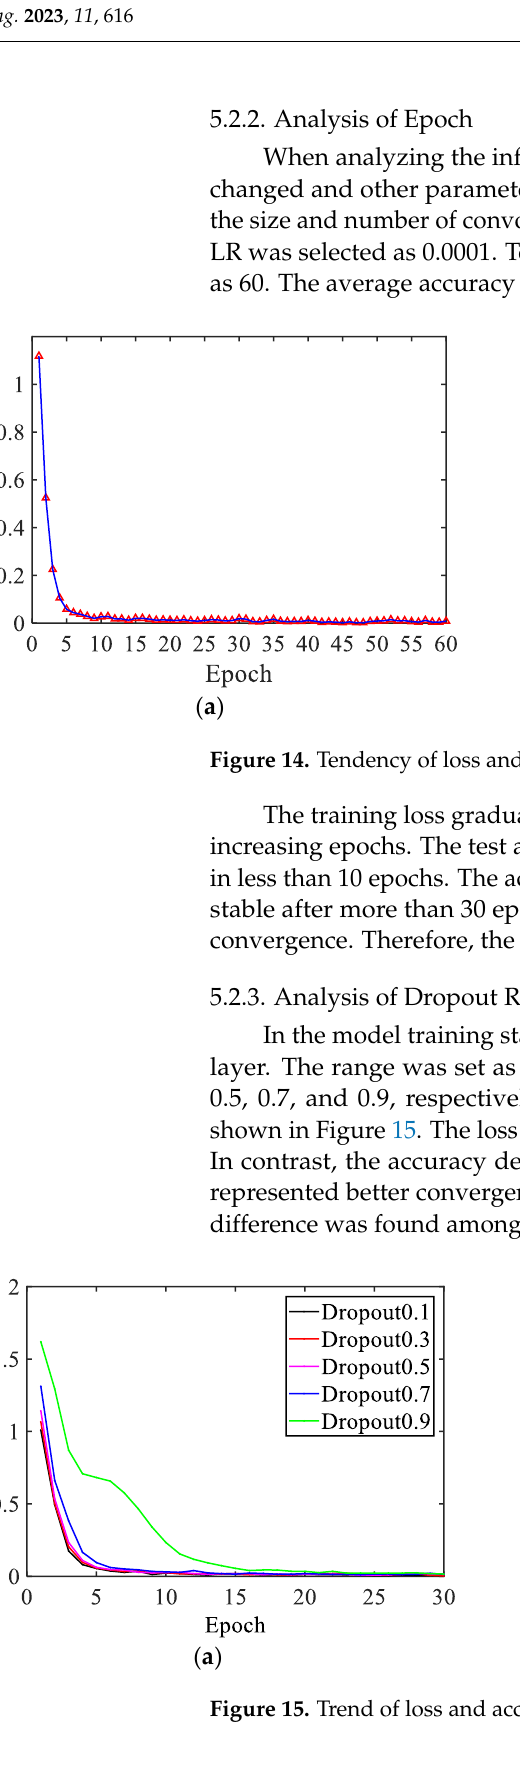
Figure 16. Classification accuracy under the different dropout ratios. 5.2.4. Effect of Batch Size on Diagnostic Accuracy The epoch was set as 30, and the batch sizes were 8, 16, 21, 32, 42, 56, 64, and 84. The average accuracy of 10 independent repeated tests is shown in Figure 17. Little difference in accuracy was found among different batch sizes, and the average was more than 99.9%. When the batch size was 21, the classification accuracy reached 100%. The model achieved good recognition for different fault categories of the axial piston pump. 0 . 1